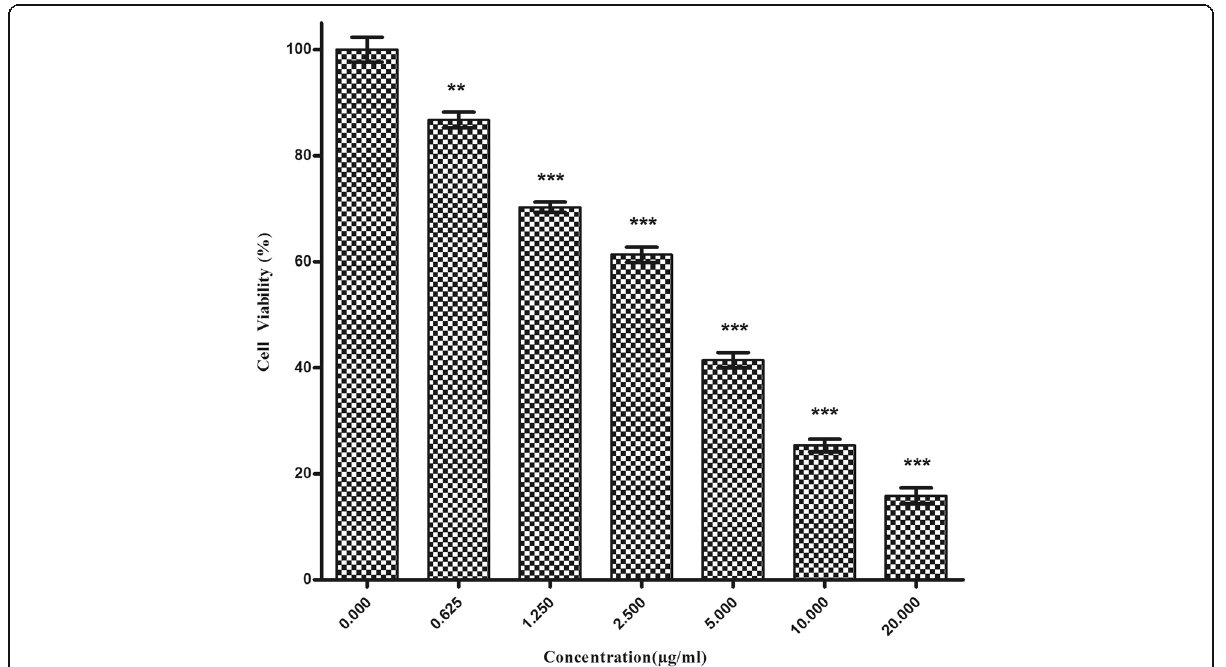
Fig. 5 Cell viability vs concentration on LNCaP cell lines